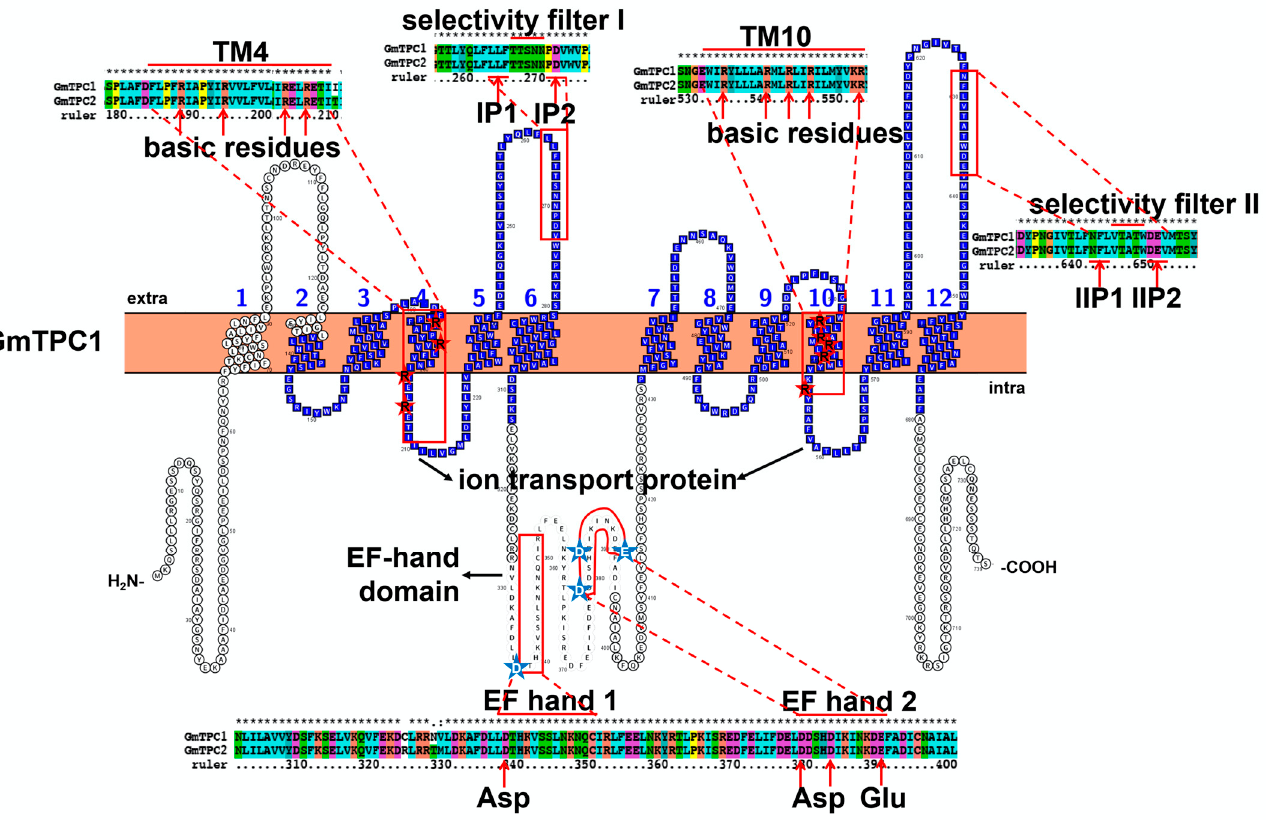
Figure 5. Topology model and homology analysis of soybean two-pore cation (TPC) channel. The red box in the topology model represents the conserved sequence in the protein sequence alignment. The red star indicates conserved basic residue (Arg), and the blue star indicates the conserved Asp or Glu in the EF-hand domain. The protein topology figure was constructed by using Protter [25]. The protein sequences were aligned by using ClustalX1.83 (http://www.clustal.org/download/, accessed on 17 October 2022).